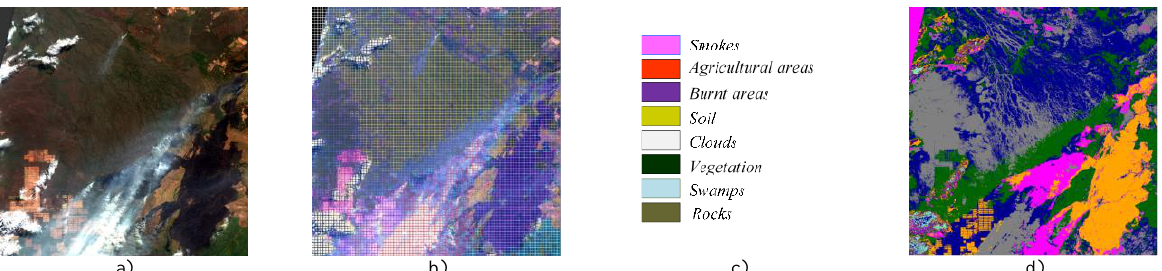
Figure 5 . An image example of the Amazon rainforest, between Brazil, Bolivia, and Paraguay on August 25th, 2019. a) The Sentinel-2 RGB (B4, B3, and B2) quick-look image, b) Our semantic classification based on active learning (with Gabor filtering as feature vector applied to each band and an SVM as classifier), and d) Our topic representation based on LDA. The active learning process is supported by a colour legend shown in c); the colour legend of LDA is similar to the one from Figure 2.